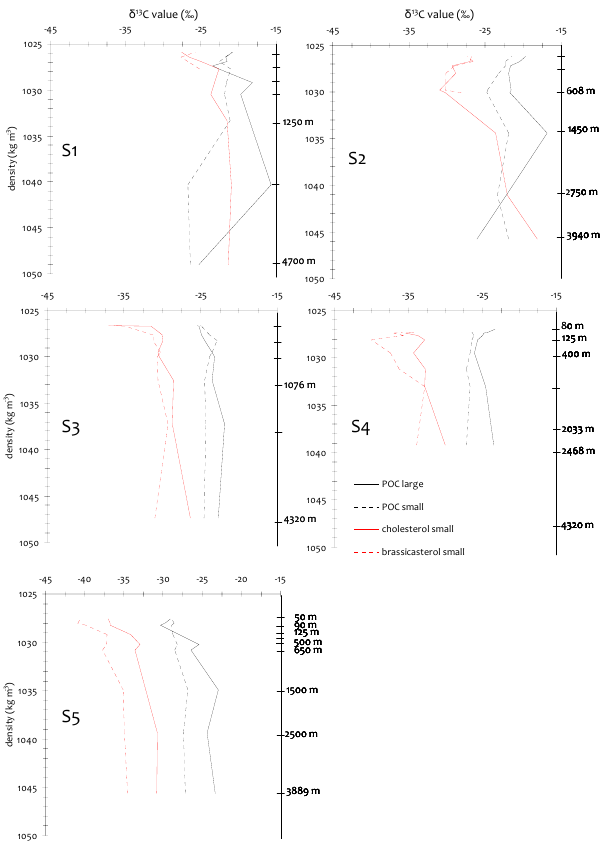
Fig. 3. Vertical profiles of δ 13 C POC (‰) for large ( > 53µm) and small (1–53µm) particles, δ 13 C cholesterol (‰) and δ 13 C brassicasterol (‰) for small particles vs. seawater density. As an indicator, right Y-axis shows depth meter scale.